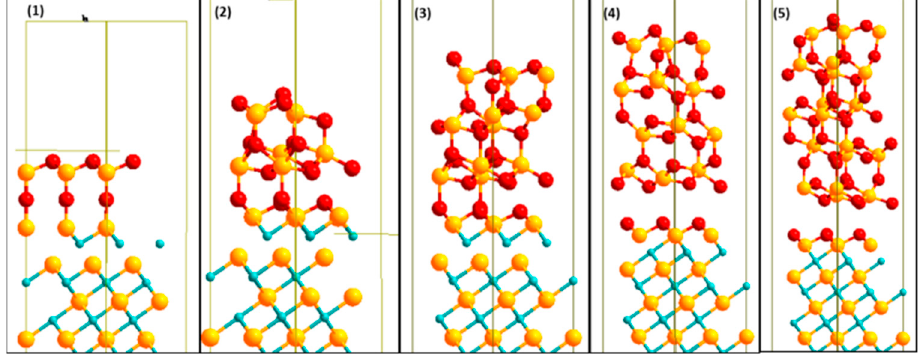
Figure 7. Relaxed stable structures for 1, 2, 3, 4, and 5 (from left to right ) c ‐ ZrO 2 (111) deposited on Zrc(111). The most stable interface model Zr|OO|Zr|OO—ZrC(111) is shown here. Yellow (Zr), light blue (C), and red (O).